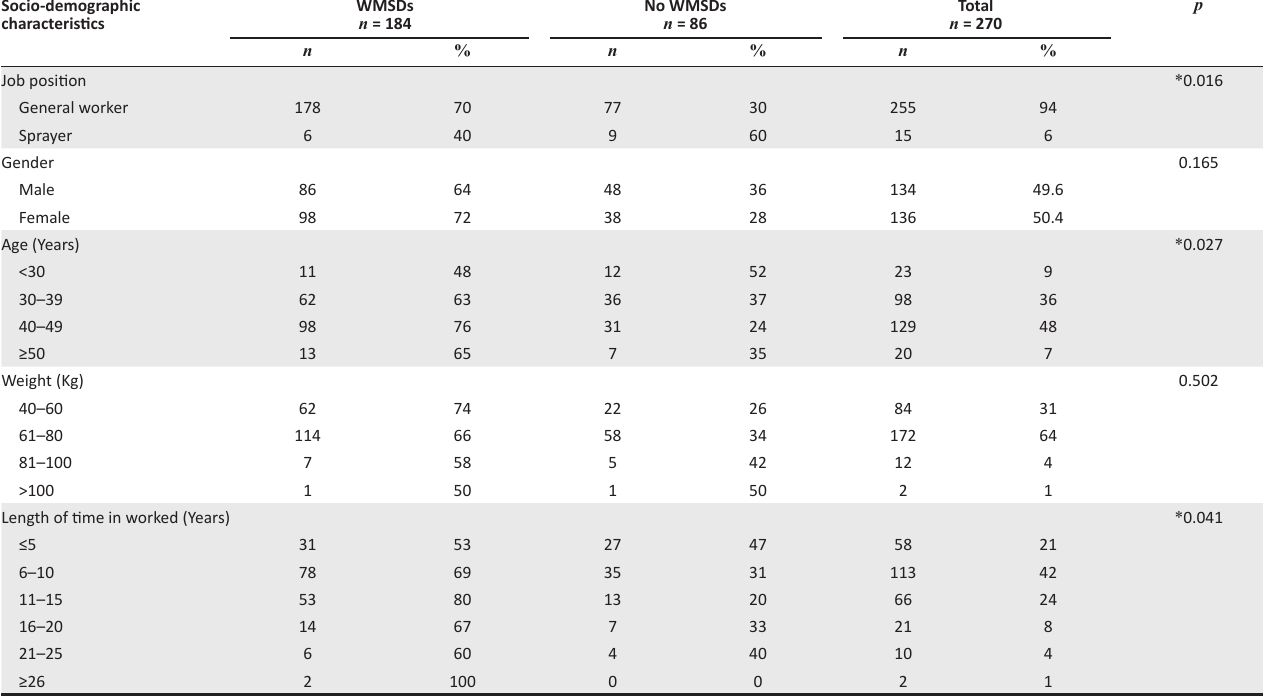
TABLE 2: Relationship between work-related musculoskeletal disorders and socio-demographic characteristics. Socio-demographic